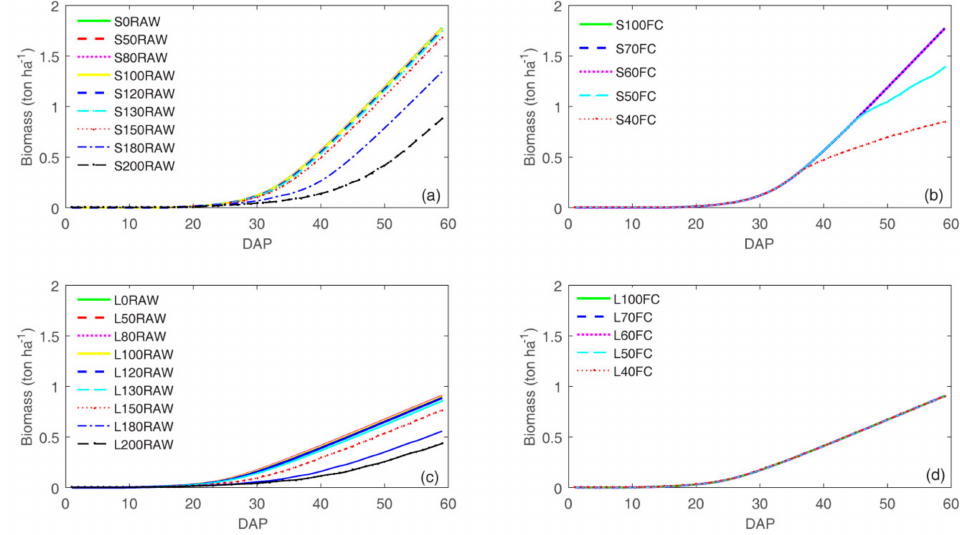
Figure 11. Biomass accumulation responses to different scenarios: ( a ) varied RAW threshold irrigation scenarios at site S1 (sand soil); ( b ) varied field capacity threshold irrigation scenarios at site S1; ( c ) varied RAW threshold irrigation scenarios at site S2 (loam soil); ( d ) varied field capacity threshold irrigation scenarios at site S2. RAW is readily available water content, S0RAW-S200RAW refers to irrigation scenarios with irrigation at 0–200% of RAW for sand soil. L0RAW-L200RAW refers to irrigation scenarios with irrigation at 0–200% of RAW for loam soil. S40FC-S100FC refers to deficit irrigation at 40–100% of field capacity for sand soil. L40FC-L100FC refers to deficit irrigation at 40–100% of field capacity for loam